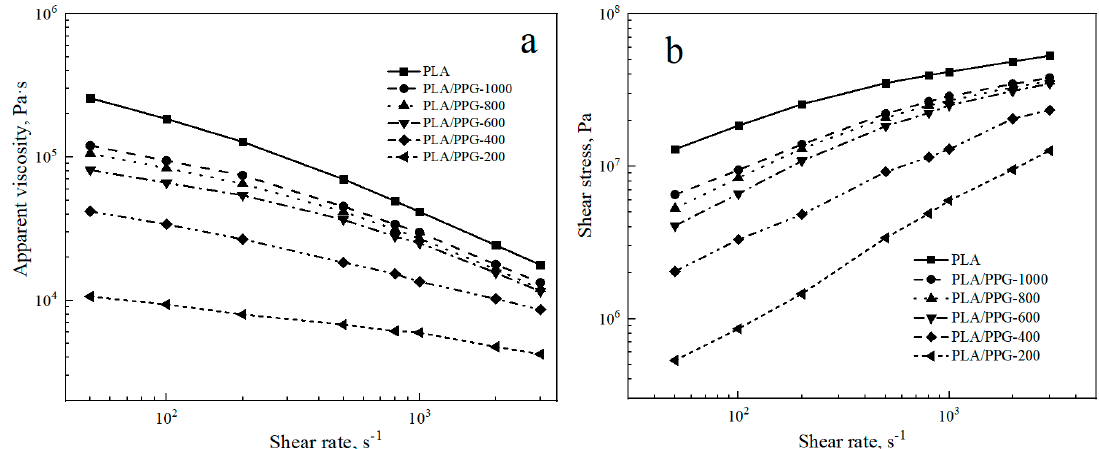
Figure 1. Neat polylactic acid (PLA) and polylactic acid / polypropylene glycol (PLA / PPG) composites capillary rheology test results: ( a ) Apparent viscosity versus shear rate curves, ( b ) shear stress versus shear rate curves.